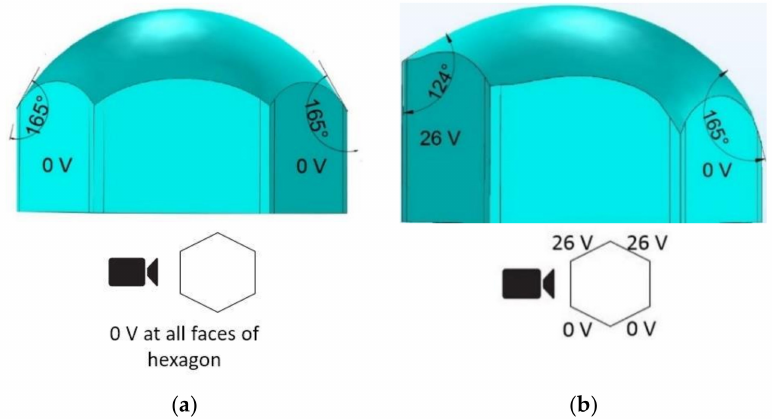
Figure 12. The simulation result (front view) of contact angle change of the bottom liquid (water) interface in a hexagonal electrowetting cell, ( a ) 0 V to all electrode faces, ( b ) 26 V applied to the two-adjacent electrode faces on the cell’s left side.